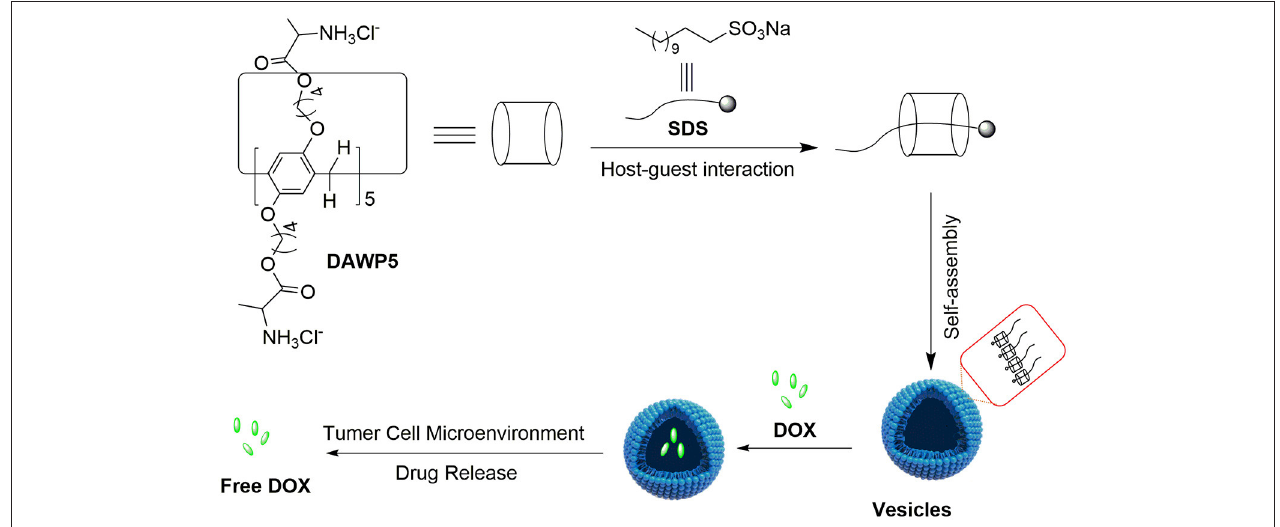
FIGURE 1 | Illustration of constructing supramolecular vesicles and the application of supramolecular vesicles in anticancer drug delivery.